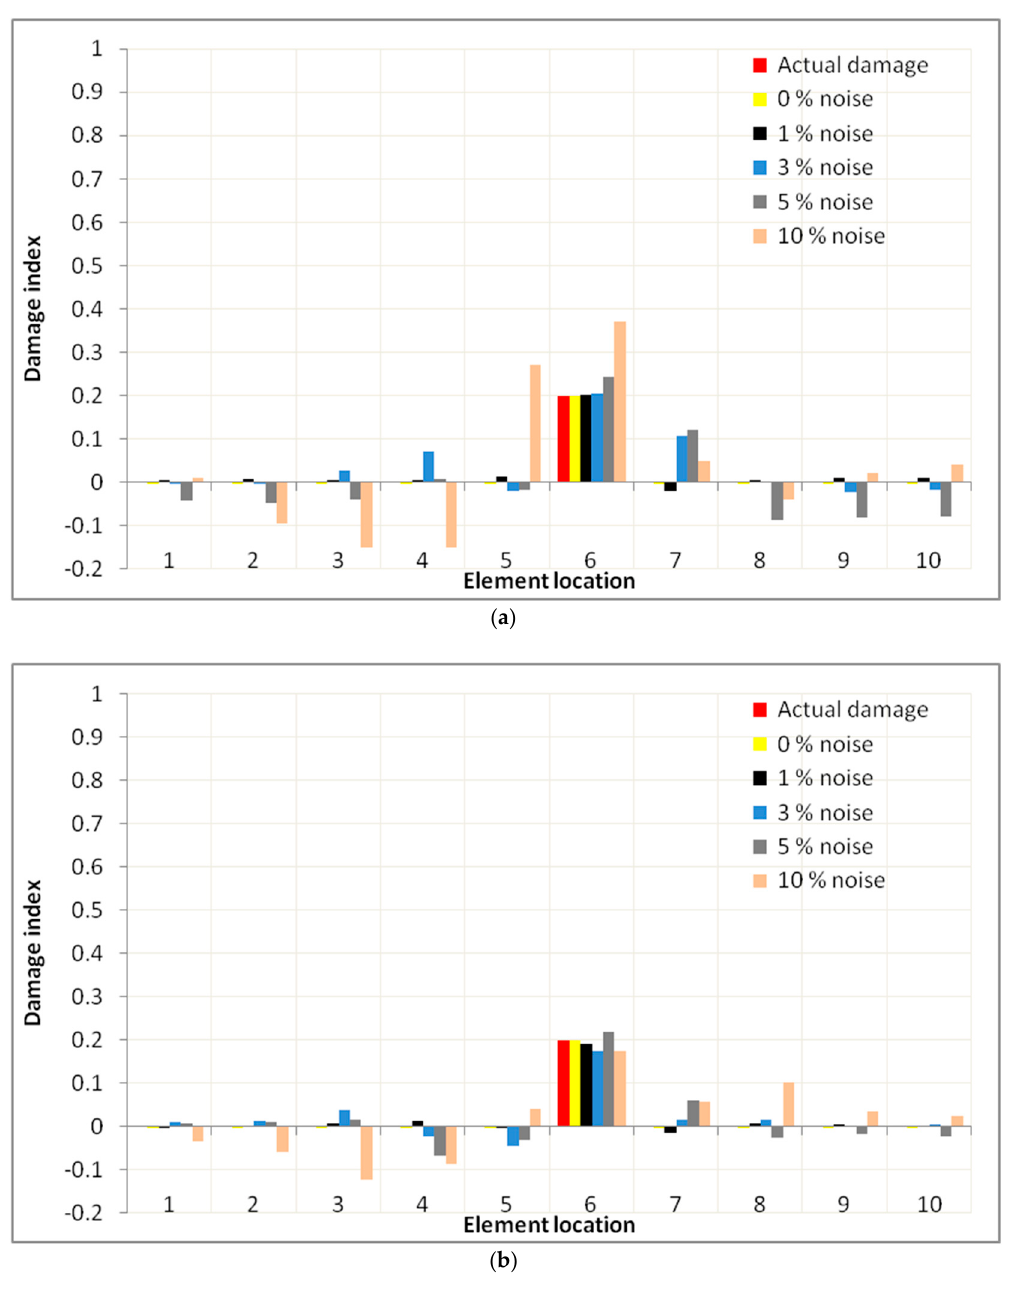
Figure 2. Damage distribution for Case 1 using Objective Function I for ( a ) noise both in frequency and mode shapes and ( b ) noise in mode shapes only.